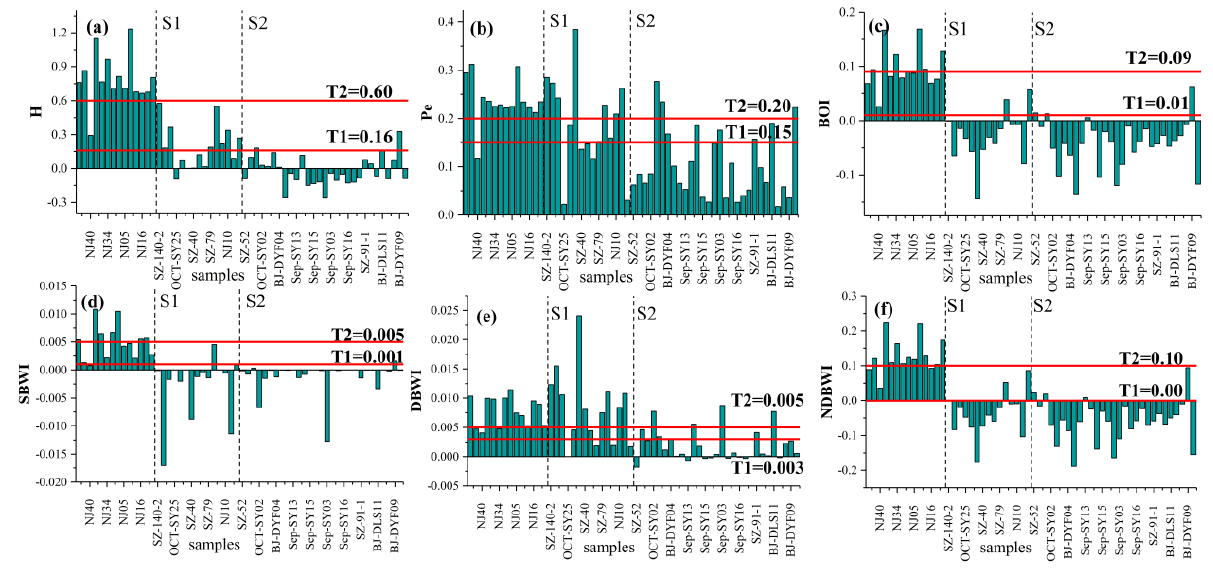
Figure 4. Model accuracy verification and comparison. ( a – f ) represent the accuracy verification results of H index, Pe, BOI, SBWI, DBWI, and NDBWI, respectively. Two red lines, T1 and T2, represent the thresholds determined by each model (distinguishing GW, MBOW, and SBOW). Two black dashed lines, S1 and S2, represent the boundaries of GW, MBOW, and SBOW, respectively.